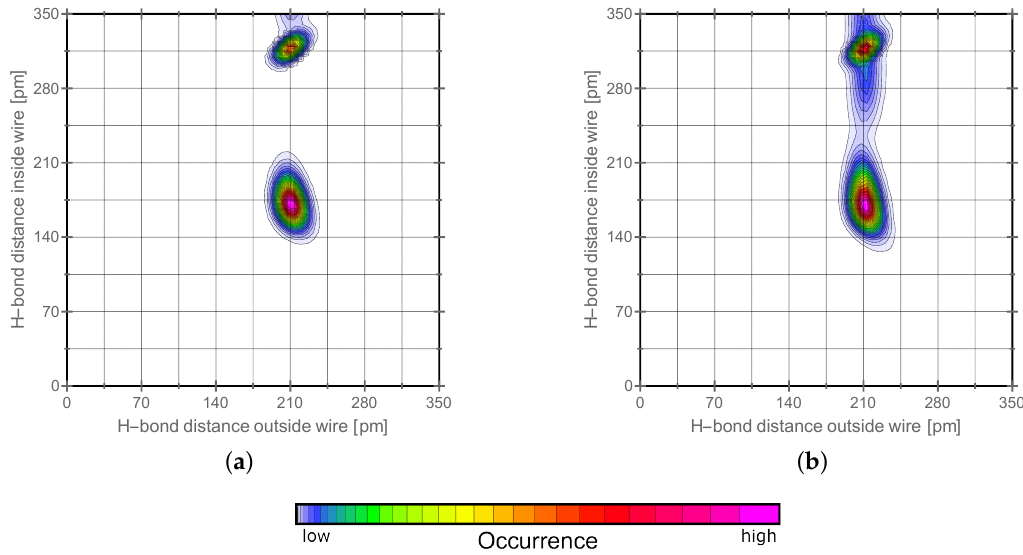
Figure 8. Shown are combined distribution functions for the orthorhombic phase left (graph ( a )) and the monoclinic phase right (graph ( b )). The criteria are the hydrogen bond distance along the wire plotted against the same distance outside the wire structure. Lowermost, the color scheme for the qualitative probability of occurrence is given which holds for all the graphs